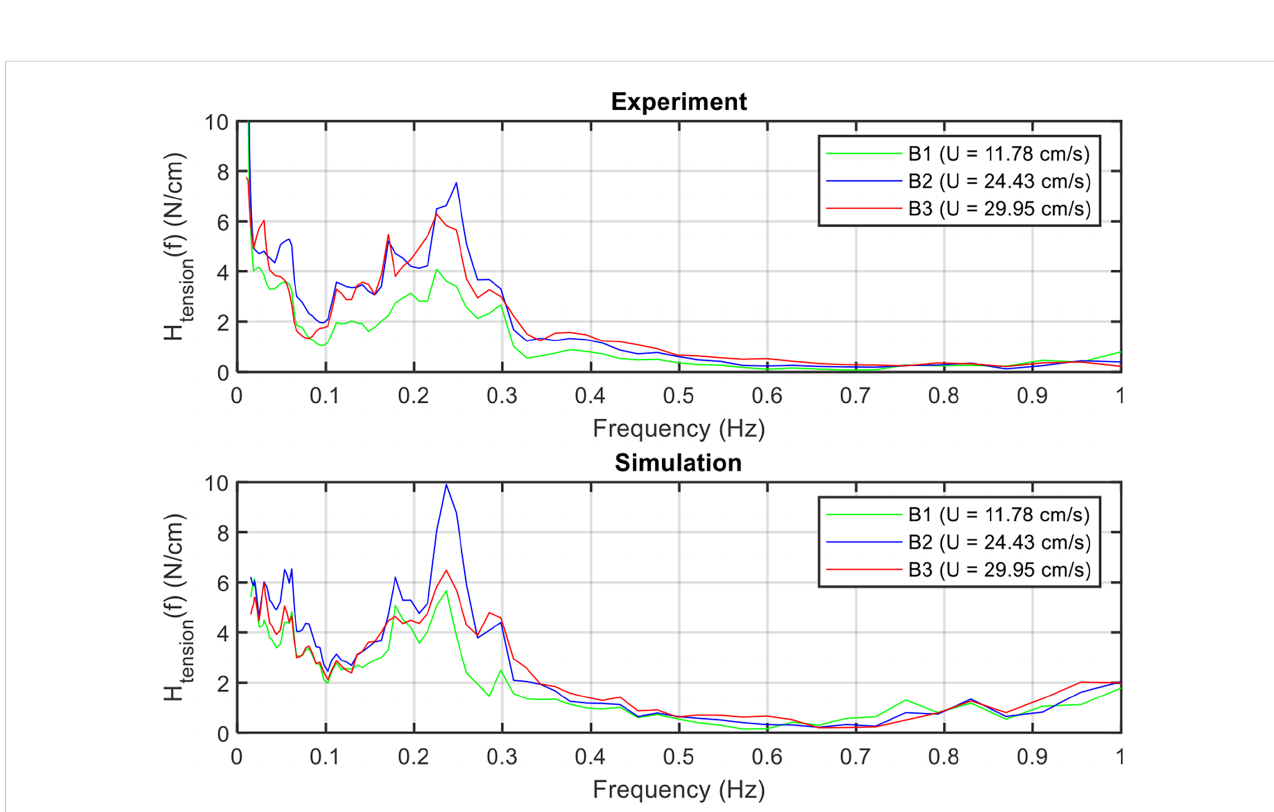
FIGURE 15 In fl uence of the current velocity on the linear transfer function of the mooring force under the mooring line failure of a net cage in irregular waves and